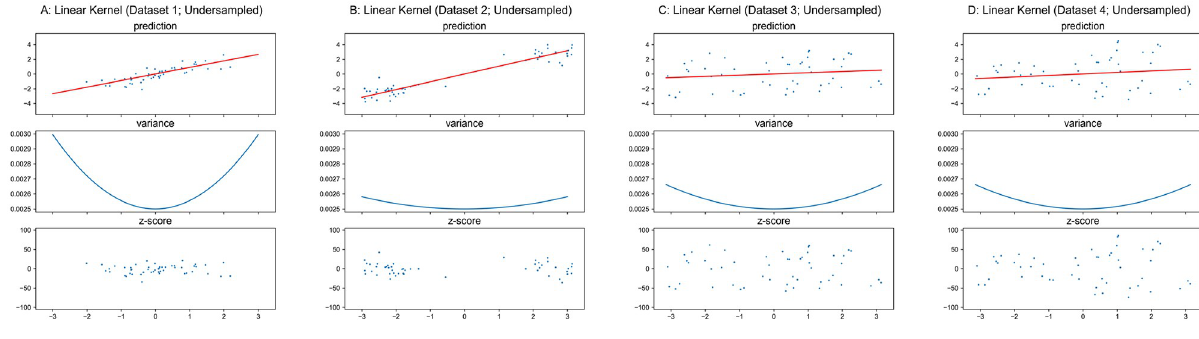
Fig 5. GPR with linear kernel on undersampled datasets.